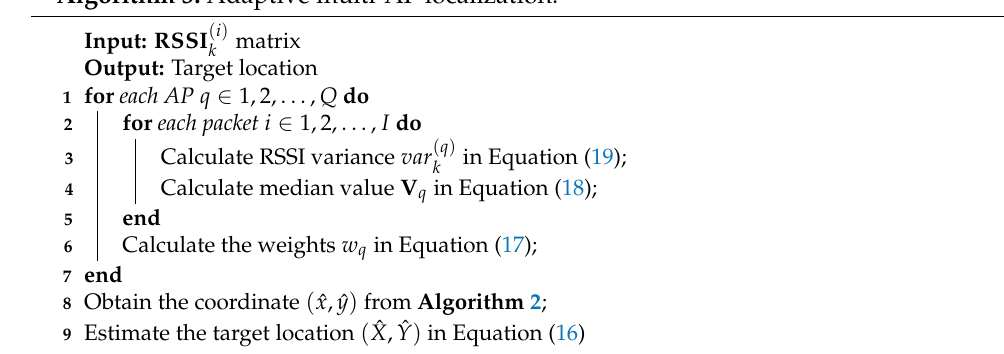
Algorithm 3: Adaptive multi-AP